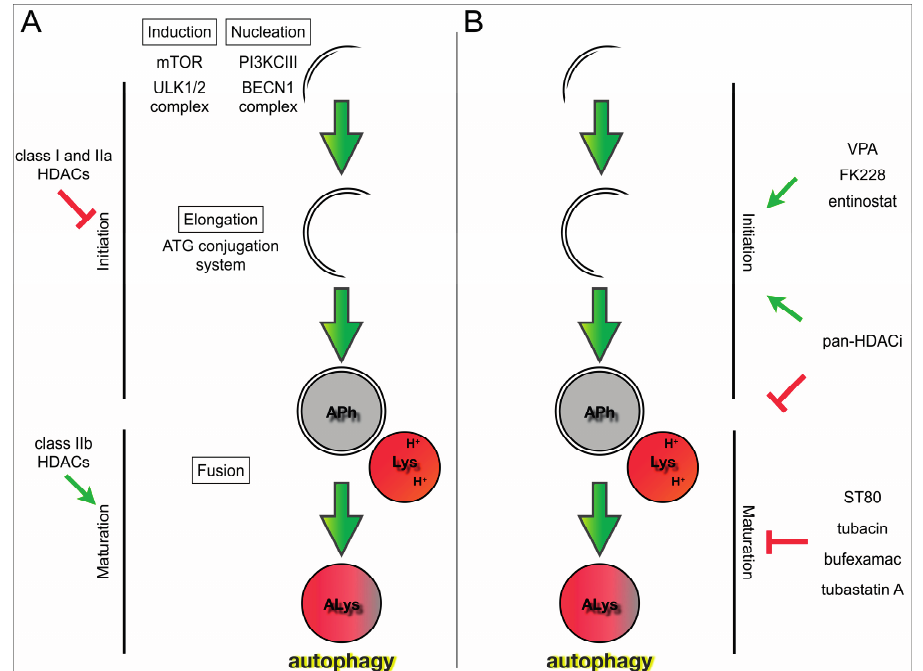
Figure 1. Histone deacetylase family members and their inhibitors modulate different phases of the autophagy